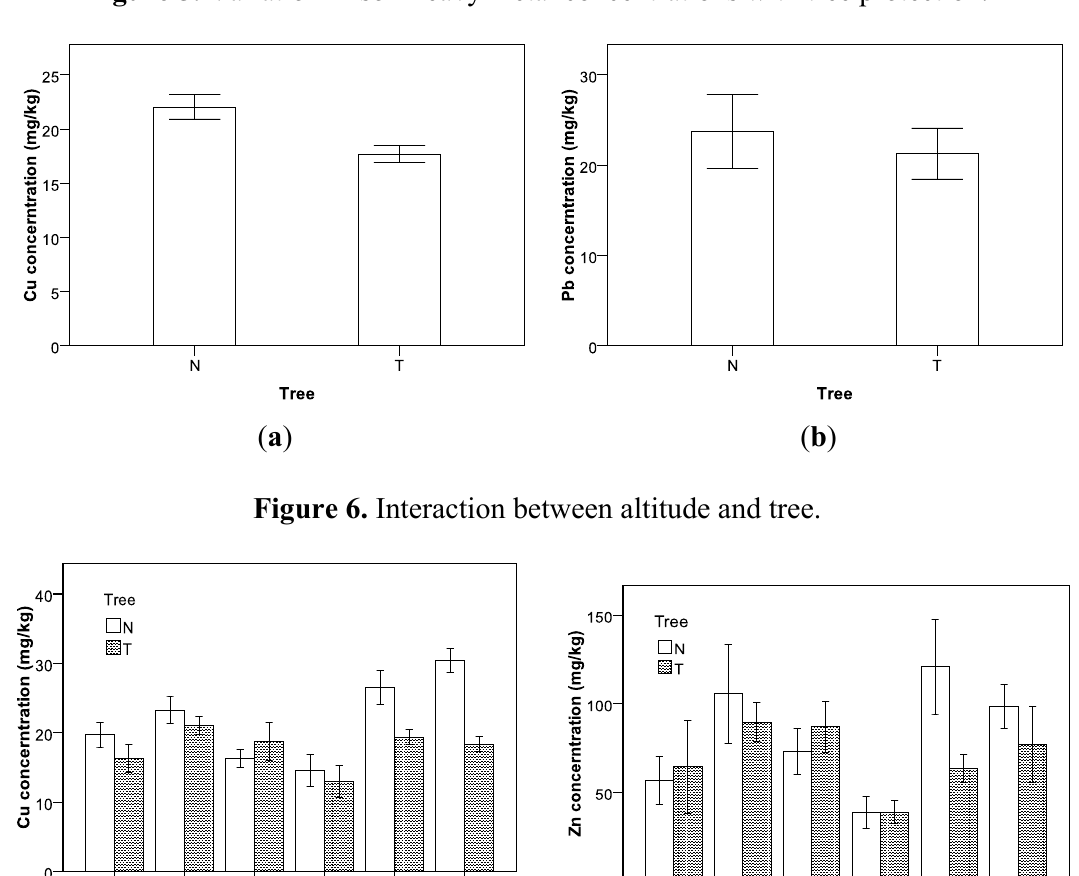
Figure 5. Variation in soil heavy metal concentrations with tree protection.